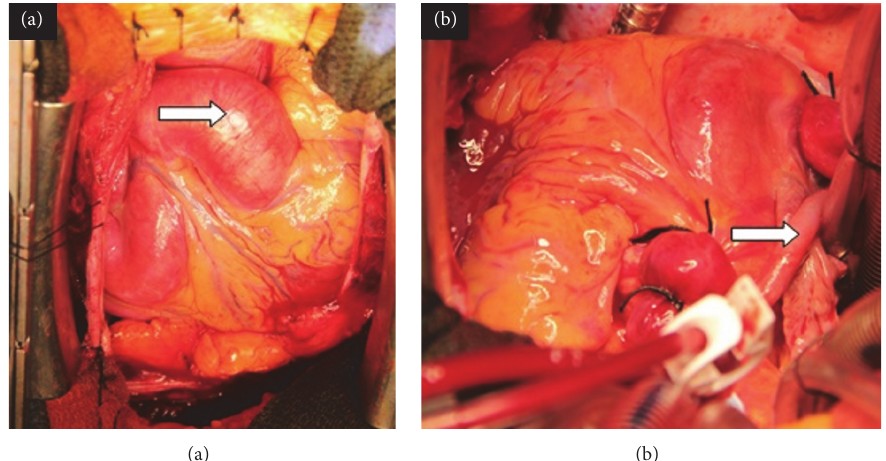
Figure 3: (a) Intraoperative view of right coronary artery aneurysm (arrow). (b) The right coronary artery aneurysm following ligation with saphenous vein graft to posterior descending artery in situ